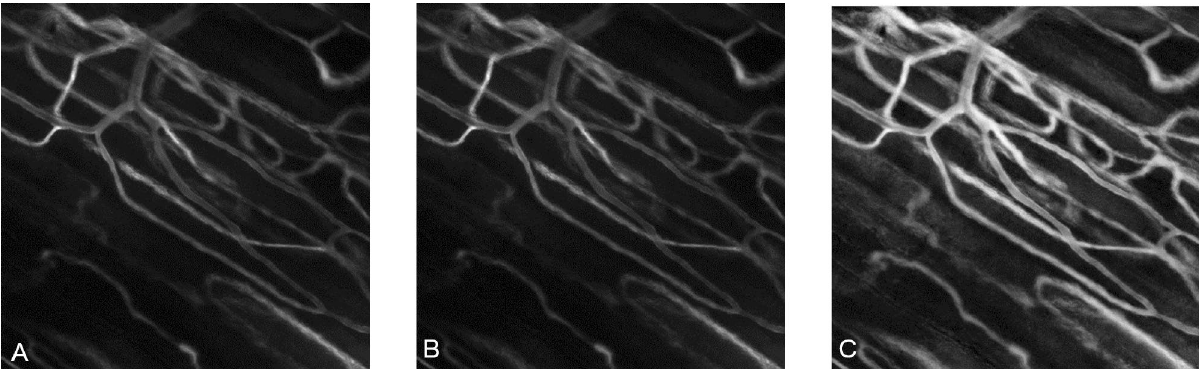
Figure 5. Image processing of the SAD image. (A) The SAD image of a FOV (400 × 400 µm) in the EDL muscle of a rat; visible are the highlighted structures associated with the vasculature. (B) Displays the SAD image after removing moving frames from the microcirculation video. (C) Presents the augmented SAD image after the pre-processing step with CLAHE is applied 45,46 .